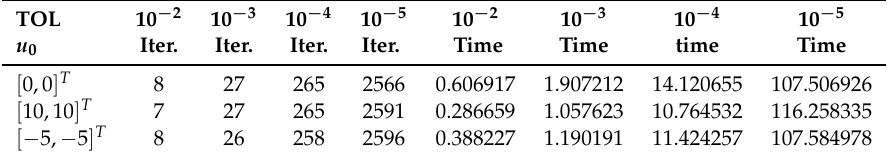
Table 3. Numerical behaviour of Algorithm 1 using different starting points for Example 3.